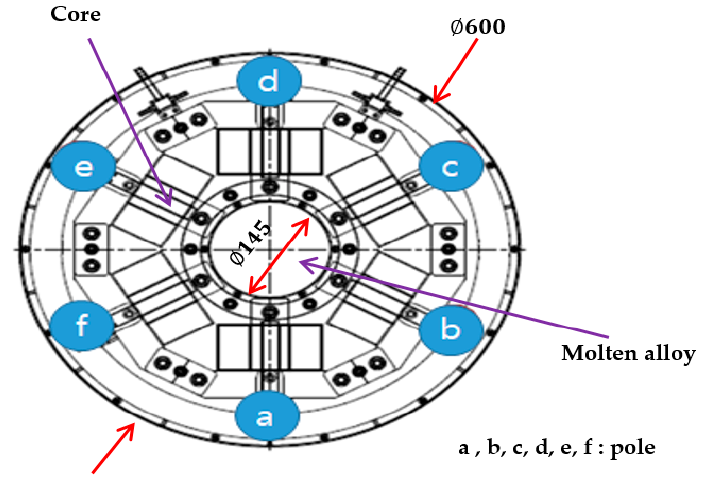
Figure 1. Scheme of electromagnetic stirring.